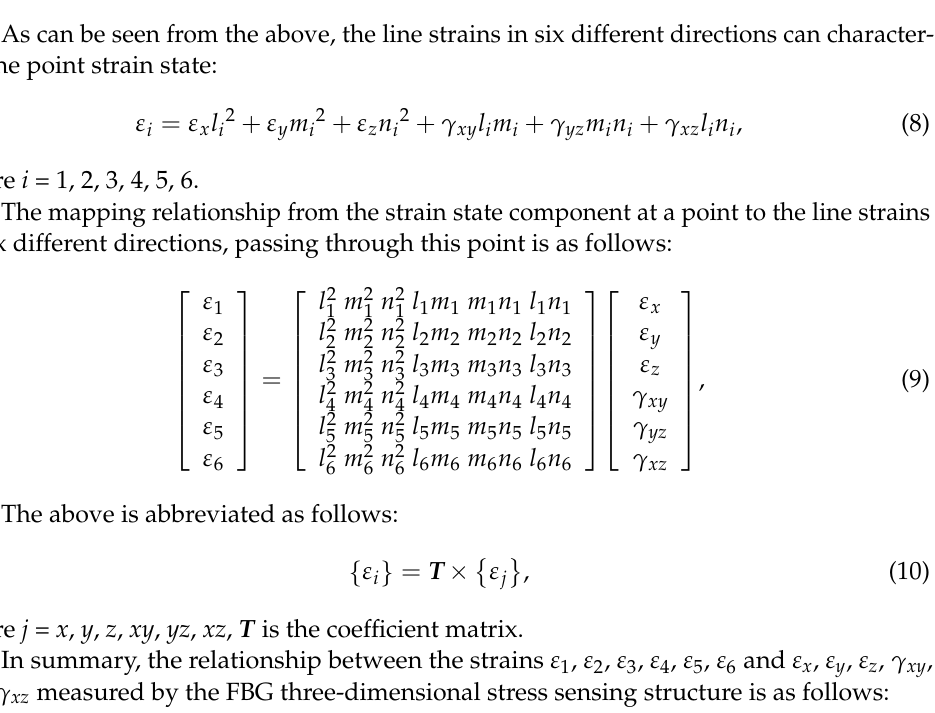
Figure 3. A linear OA in three-dimensional space. The strain state of O at any point in the surrounding rock is ε j = according to the formula of linear strain in any direction of elastic mechanics space, the linear strain in OA direction is